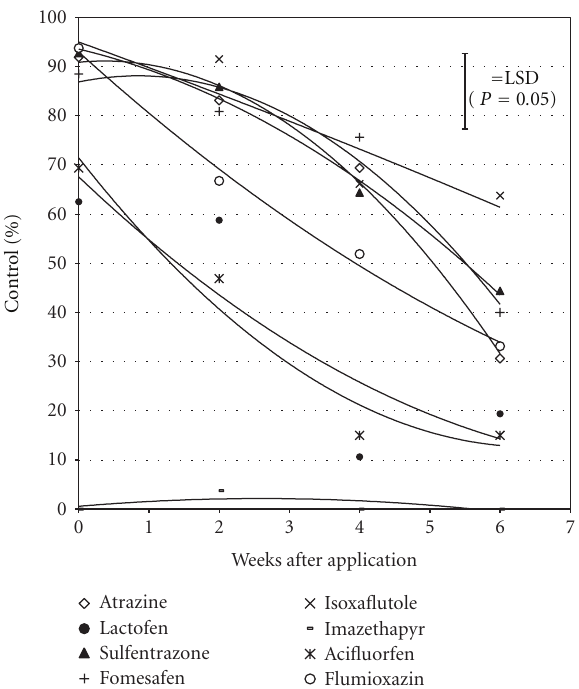
Figure 1: Preemergence control of common waterhemp with aci- fluorfen ( y = 1 . 4063 x 2 − 18 . 188 x +71 . 438, R 2 = 0 . 96), flumioxazin ( y = 0 . 5156 x 2 − 12 . 931 x + 92 . 95, R 2 = 0 . 99), fomesafen ( y = − 1 . 75 x 2 + 2 . 9625 x + 86 . 862, R 2 = 0 . 96), lactofen ( y = 0 . 7813 x 2 − 13 . 563 x + 67 . 562, R 2 = 0 . 76), sulfentrazone ( y = − 0 . 8203 x 2 − 3 . 4094 x + 93 . 556, R 2 = 0 . 99), atrazine ( y = − 1 . 875 x 2 + 1 . 375 x + 90 . 875, R 2 = 0 . 99), imazethapyr ( y = − 0 . 2344 x 2 +1 . 2188 x +0 . 5625, R 2 = 0 . 4), and isoxaflutole ( y = − 0 . 0781 x 2 − 5 . 1312 x + 94 . 987, R 2 = 0 . 85) 28 days after planting when planted 0, 2, 4, and 6 weeks after the herbicide application. The vertical line represents the LSD ( P = 0 . 05).